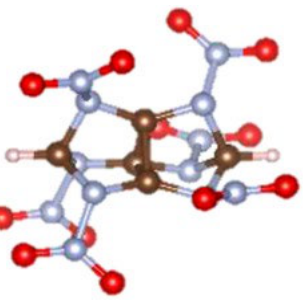
Figure 12. Molecular structures of the as-screened 31 N-containing molecules [23]. Copyright 2021 Wiley-VCH GmbH.